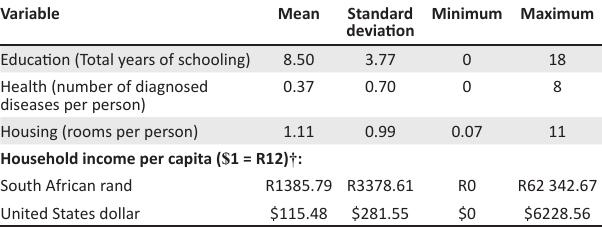
Minimum Maximum deviation